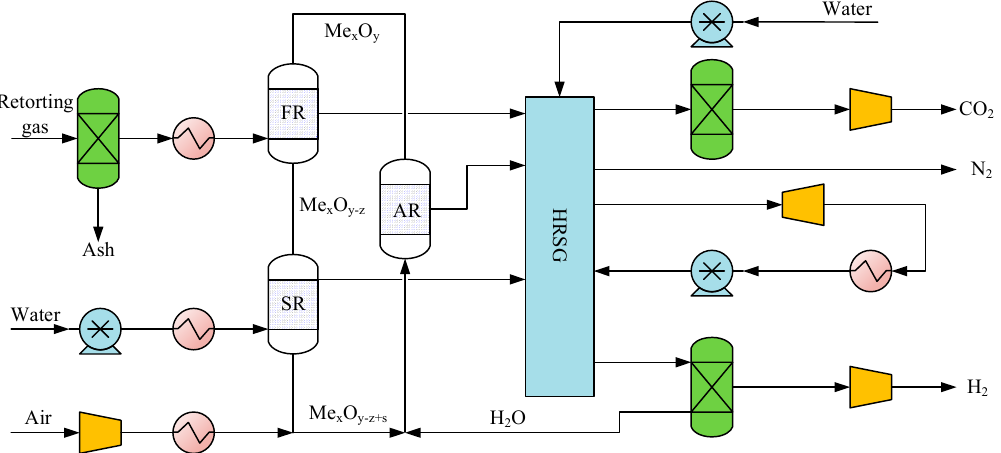
Figure 5. Flow diagram of the RGCLH process.